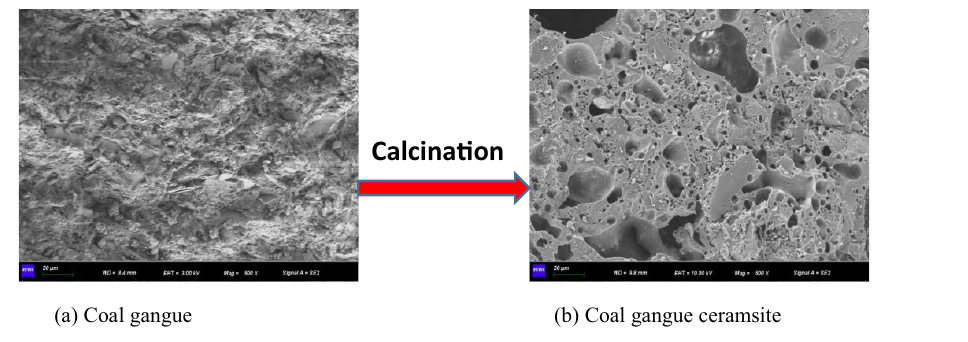
Figure 2. Change of microscopic